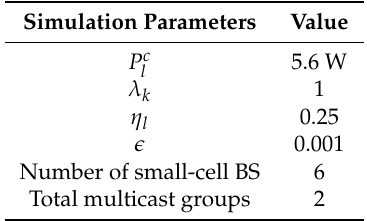
Table 1. Simulation parameters and their